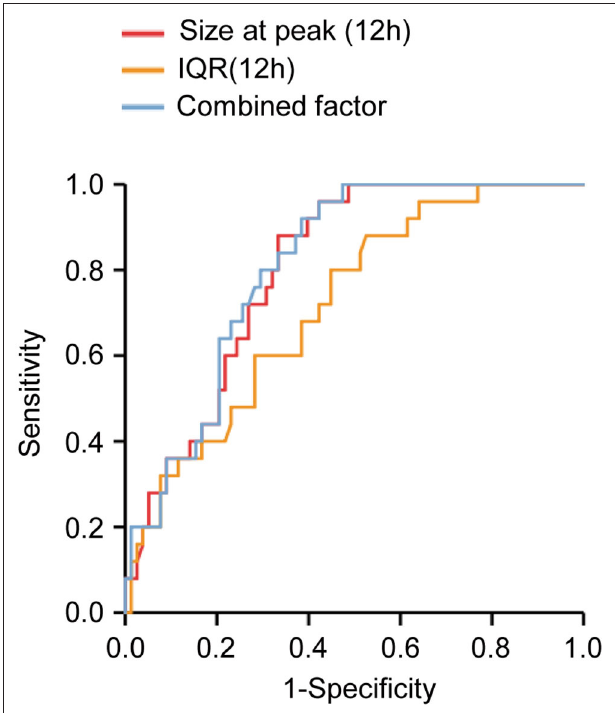
FIGURE 7 | Receiver operating characteristic curve analysis of microparticles (MPs) size distribution determined at 12h after operation. The areas under the curves were 0.803, 0.717, and 0.809 for size at peak (12H), IQR (12H), and the combined factor, respectively. Size at peak (12H), the size at peak at 12h after operation; IQR (12H), the IQR at 12h after operation; combined factor, the combined factor of size at peak (12H) and IQR (12H).